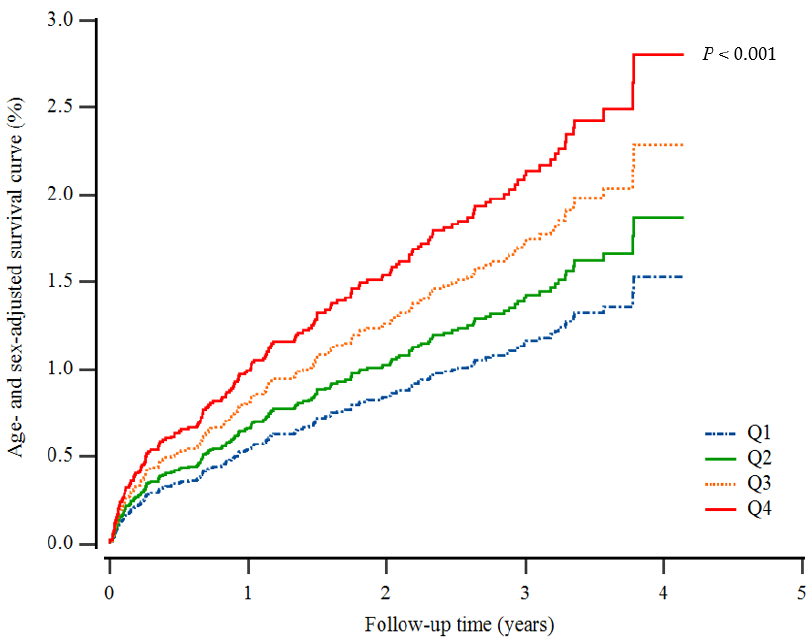
Figure 2. Cox regression survival curve for the incidence of ischemic heart disease. For the subgroup analysis by sex-specific quartile, the GGT values were categorized into Q1 ( ≤ 19), Q2 (20–26), Q3 (27–38), and Q4 ( ≥ 39.0) in men and Q1 ( ≤ 12), Q2 (13–15), Q3 (16–20), and Q4 ( ≥ 21) in women. Compared with men, women showed higher HRs